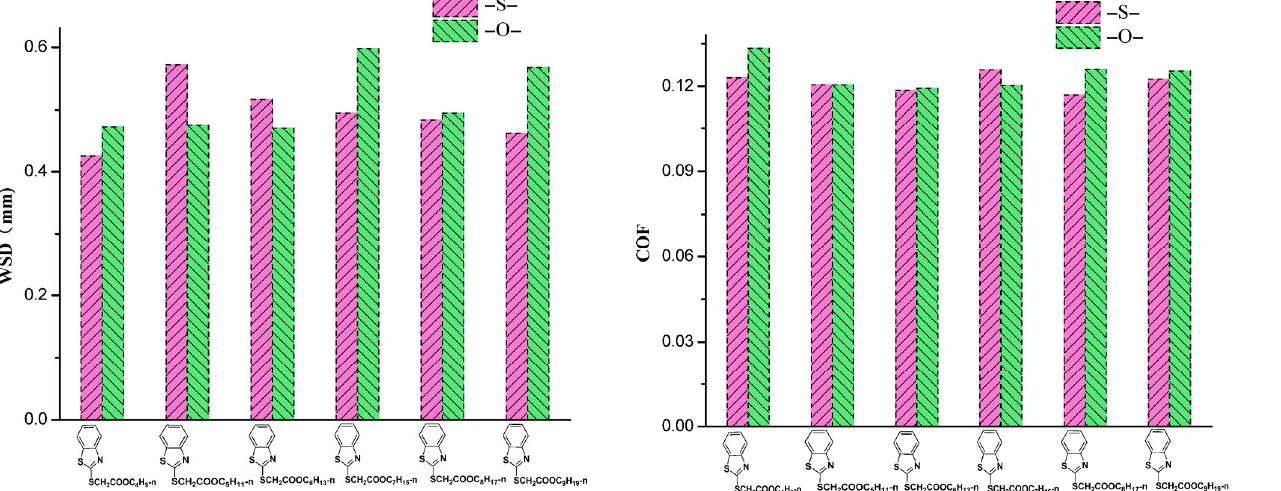
Fig. 23 The friction coefficient when lubricating with 2- benzothiazole-S-carboxylic acid esters and their isosteres in bis(2-ethylhexyl)